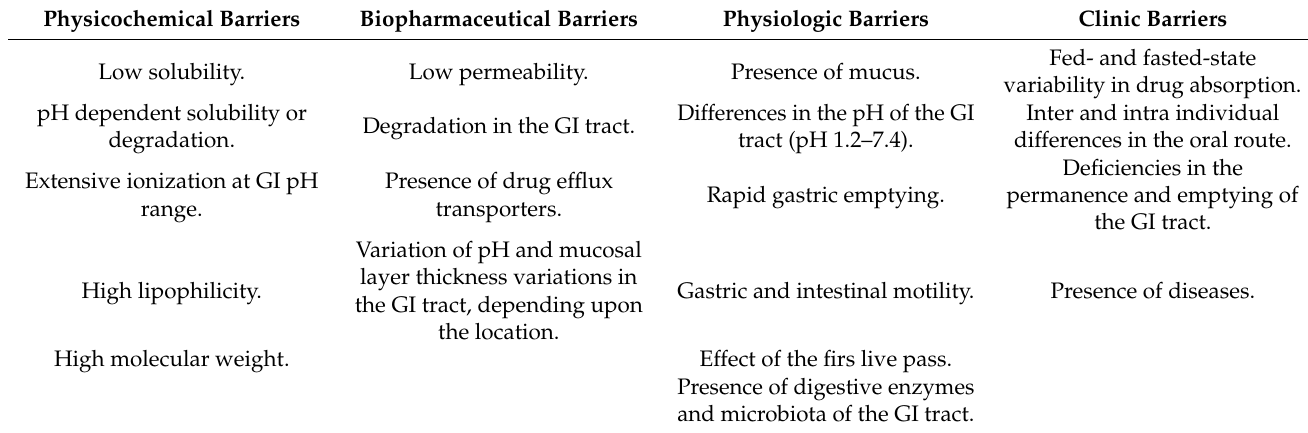
Table 3. Challenges/barriers for oral drug